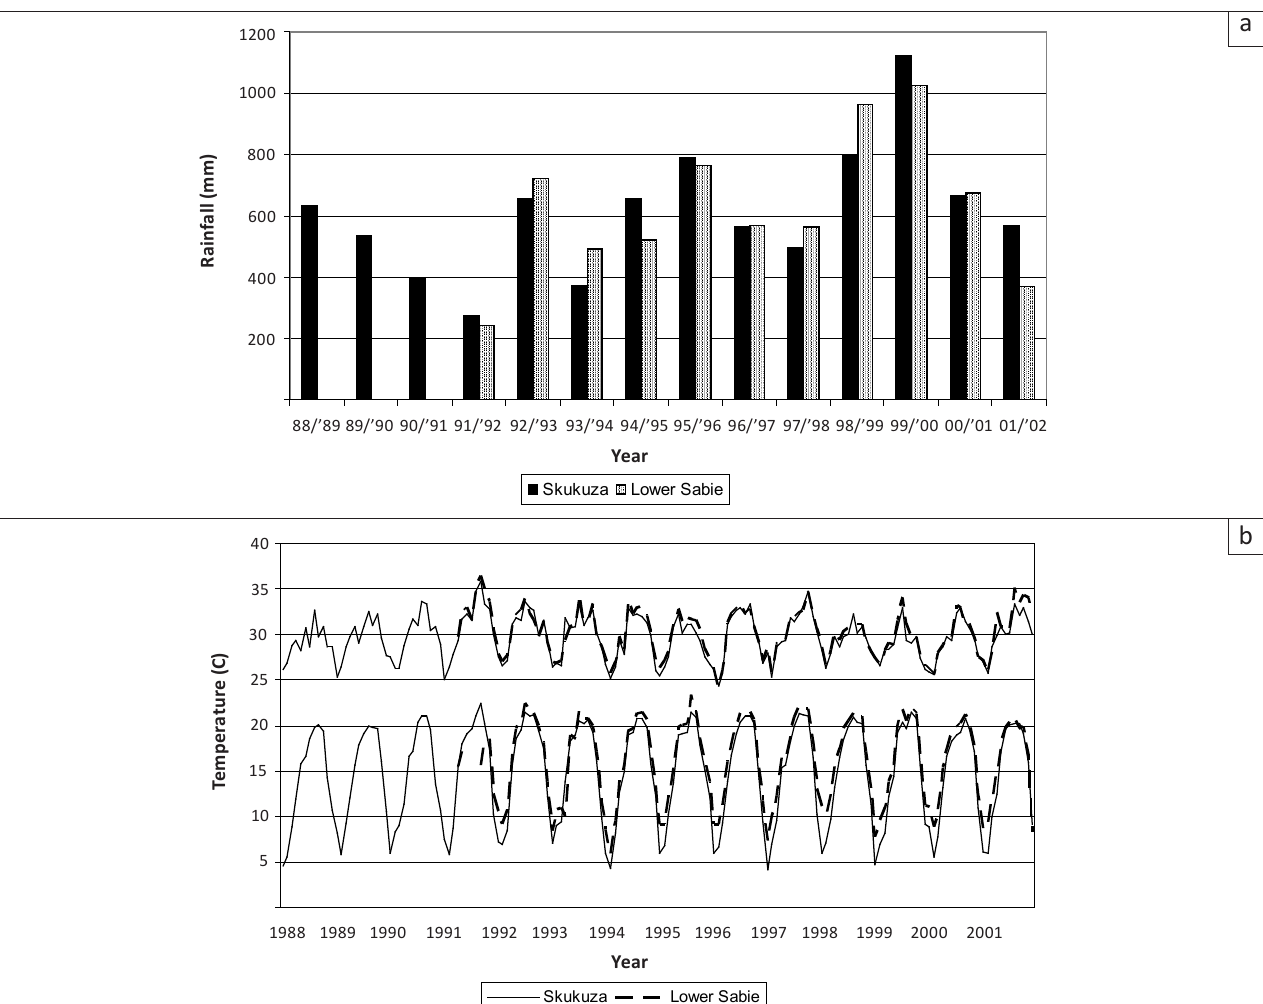
FIGURE 1: (a) Annual rainfall (June−May) and (b) mean monthly maximum and minimum temperatures at Skukuza and Lower Sabie a , during the study